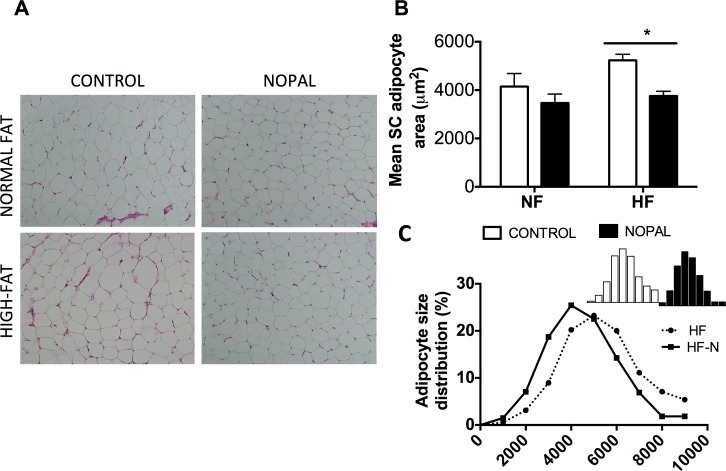
Effect of nopal consumption on adipocyte morphology A) Representative photographs with 100x magnification of H&E stained sections of subcutaneous adipose tissue from rats fed NF, NF + nopal, HF, or HF + nopal. B) Mean adipocyte size of subcutaneous adipose tissue. C) Adipocyte size distribution in high fat fed rats. Data are presented as mean ± SEM (n = 5–14 per group). Significance is set at P < 0.05.